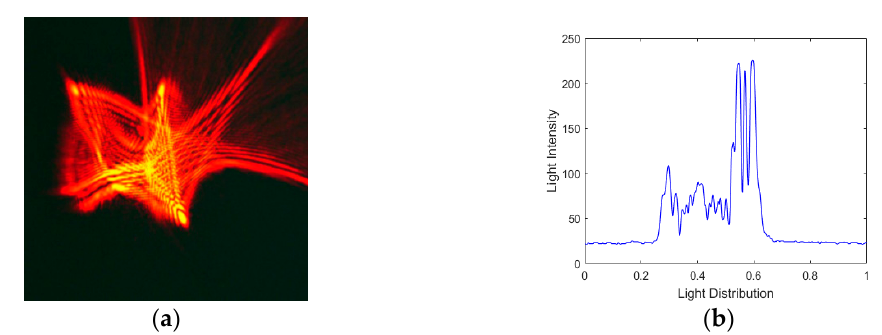
Figure 6. Target aberration. ( a ) Zernike mode numbers of the target aberration; ( b ) the aberration wavefront. Int. J. Mol. Sci. 2019 , 20 , x